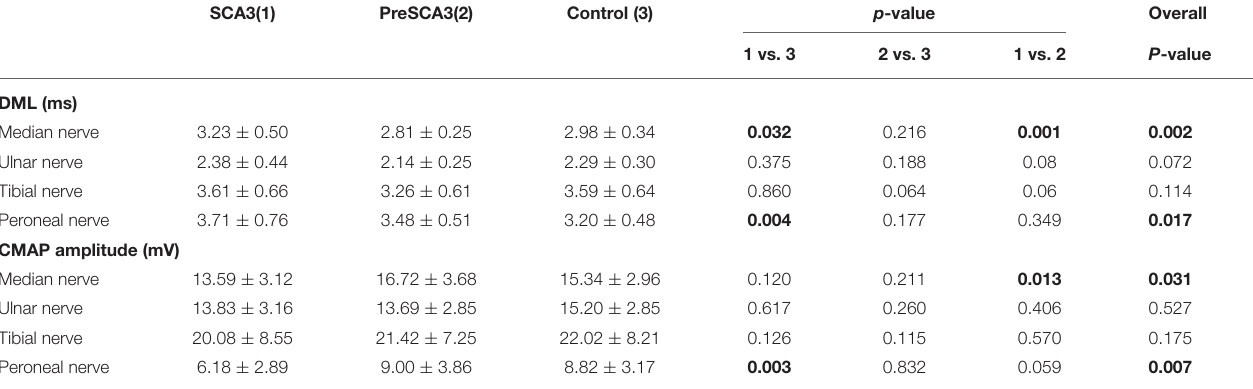
TABLE 2 | Results of nerve conduction studies.